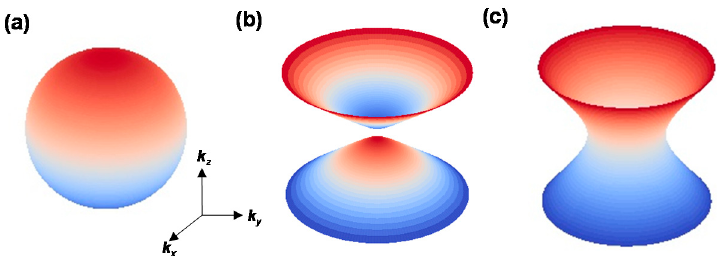
Figure 5. Isofrequency surfaces of ( a ) conventional (non-hyperbolic) materials ( ε ∥ = ε ⊥ < 0), ( b ) Type-I hyperbolic materials ( ε ∥ < 0, ε ⊥ > 0), and ( c ) Type-II hyperbolic materials ( ε ⊥ < 0, ε ∥ > 0).